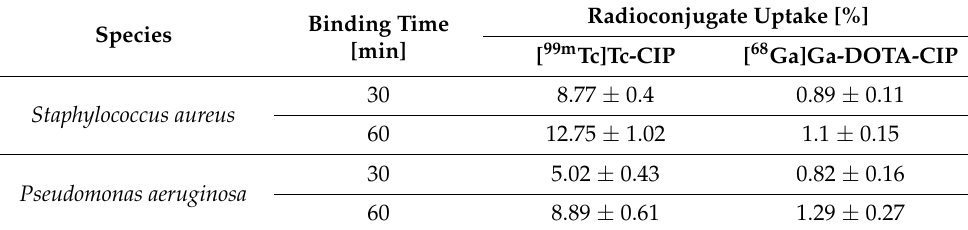
Table 2. Results of the in vitro [ 99m Tc]Tc-CIP and [ 68 Ga]Ga-DOTA-CIP binding study to Staphylococcus aureus and Pseudomonas aeruginosa . Binding Species